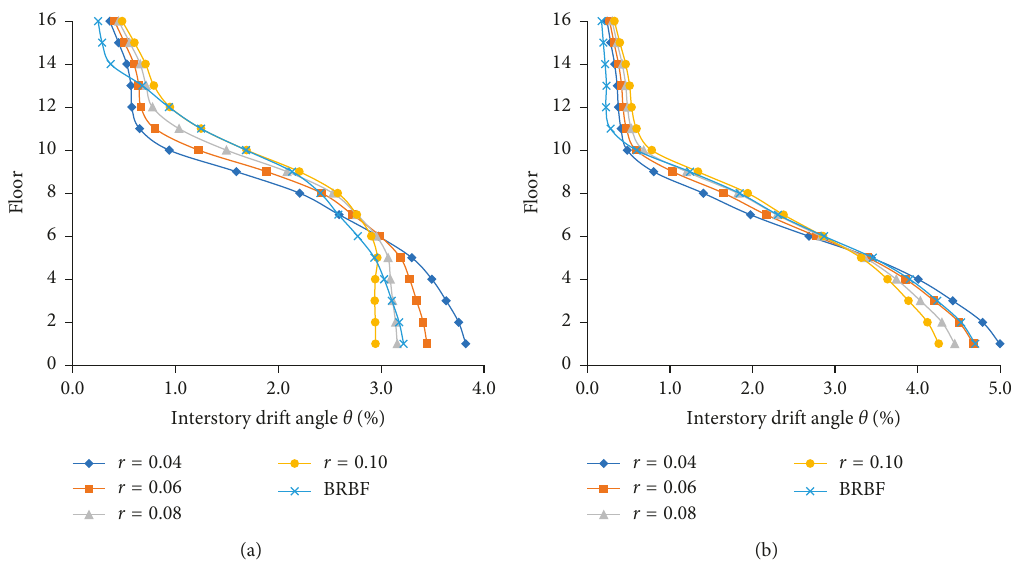
Figure 15: The effects of r on the interstory drifts of 16-story SC-TOBFs: (a) LD-1 and (b) LD-2.